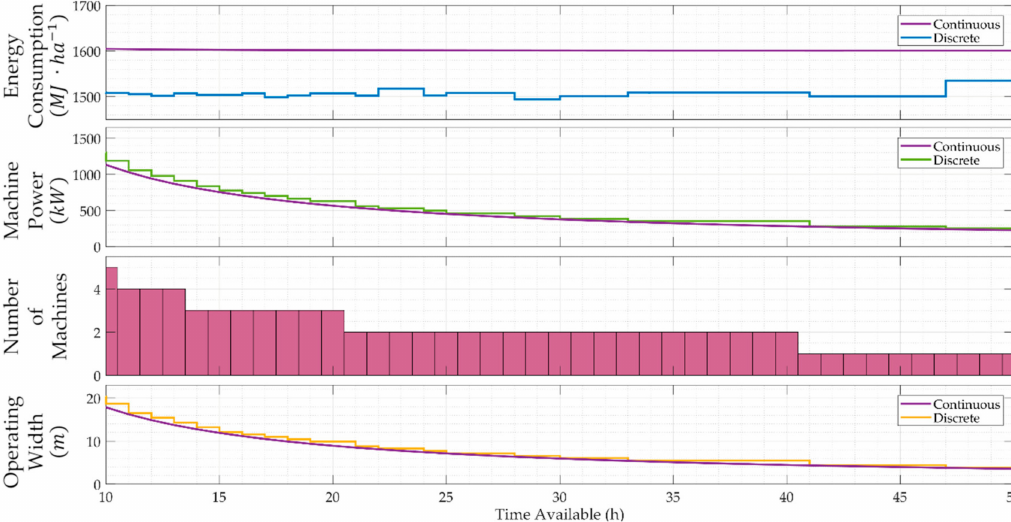
Figure 7. Energy consumption, machine power, number of machines, and operating width for a cultivated area of 100 ha (moldboard